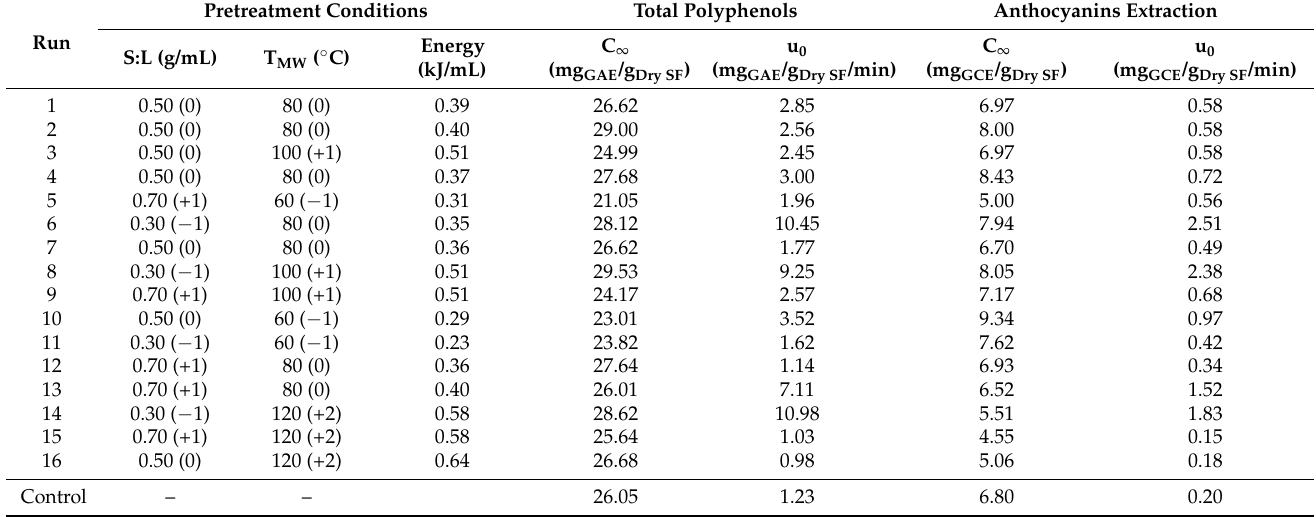
Table 5. Experimental pretreatment operating variables and extraction kinetics